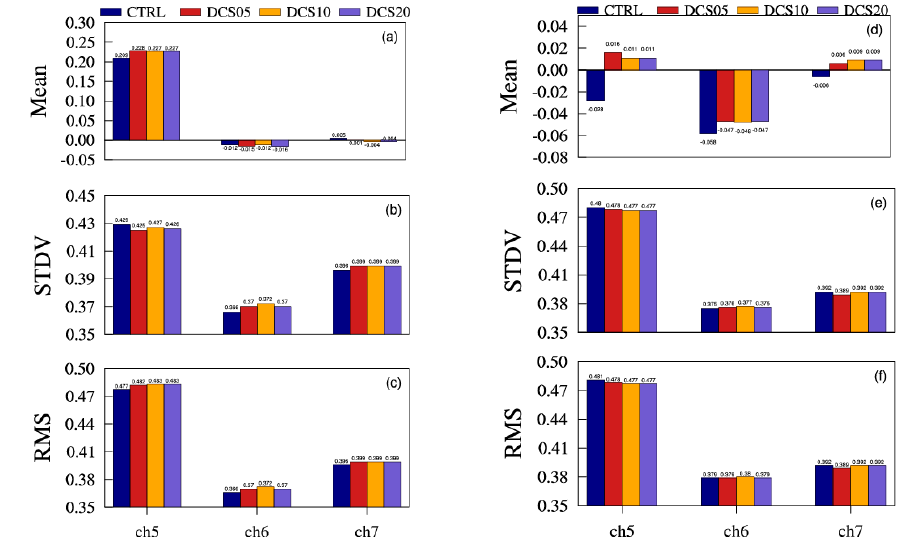
Figure 10. Mean, standard deviation (STDV) and root mean square (RMS) of O-B for MWTS-2 channels 5–7 for all four experiments conducted at ( a – c ) 0600 UTC and ( d – f ) 1200 UTC on December 10, 2018. The dark blue columns are the O-B errors for all three channels in CTRL; red columns correspond to DCS05, orange columns to DCS10 and purple columns to DCS20.